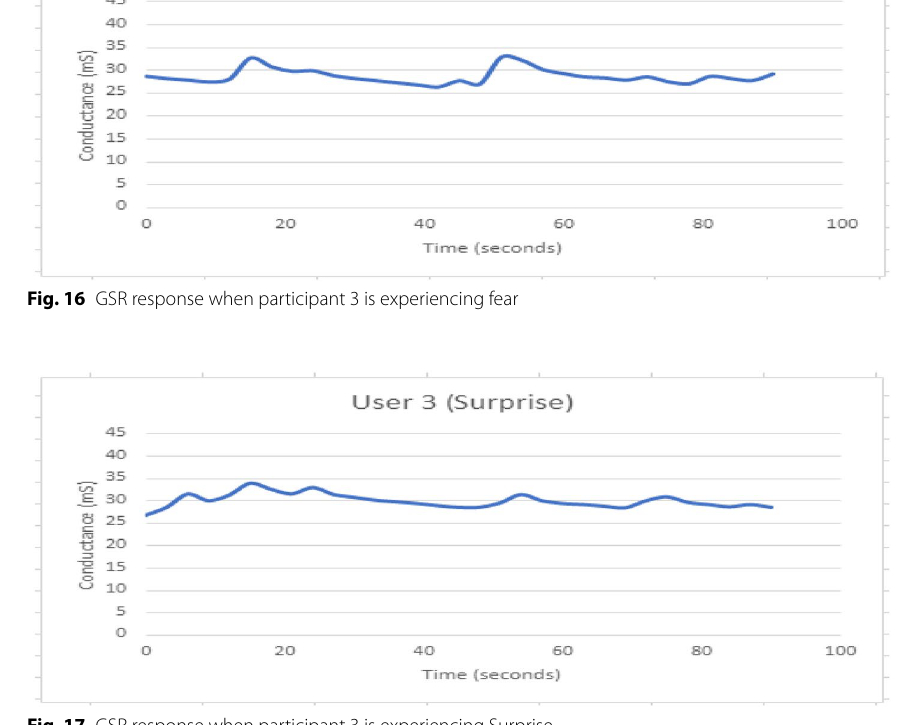
Fig. 17 GSR response when participant 3 is experiencing